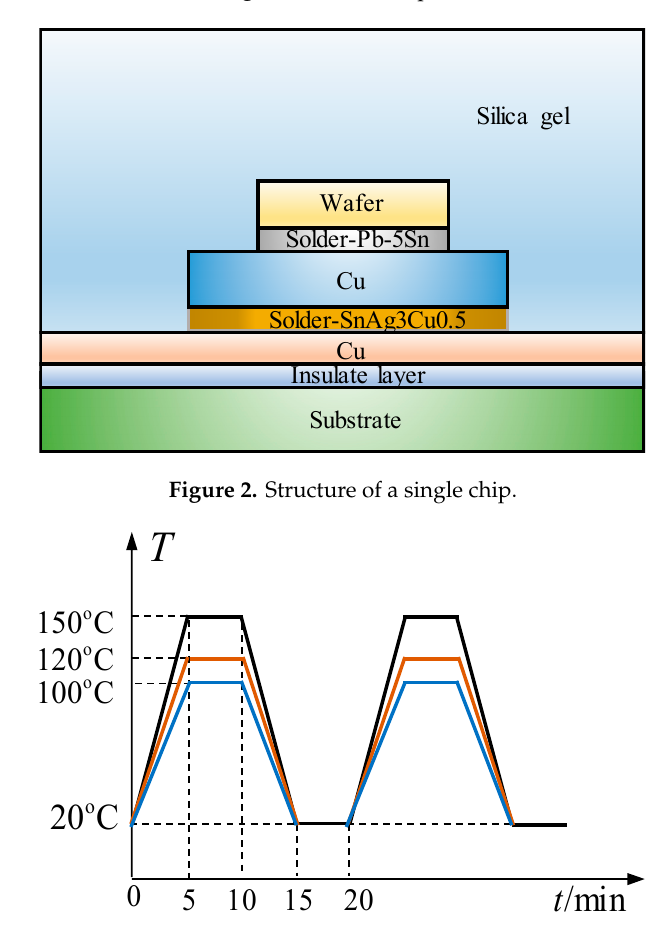
Figure 3. Temperature cycle for thermal fatigue tests.